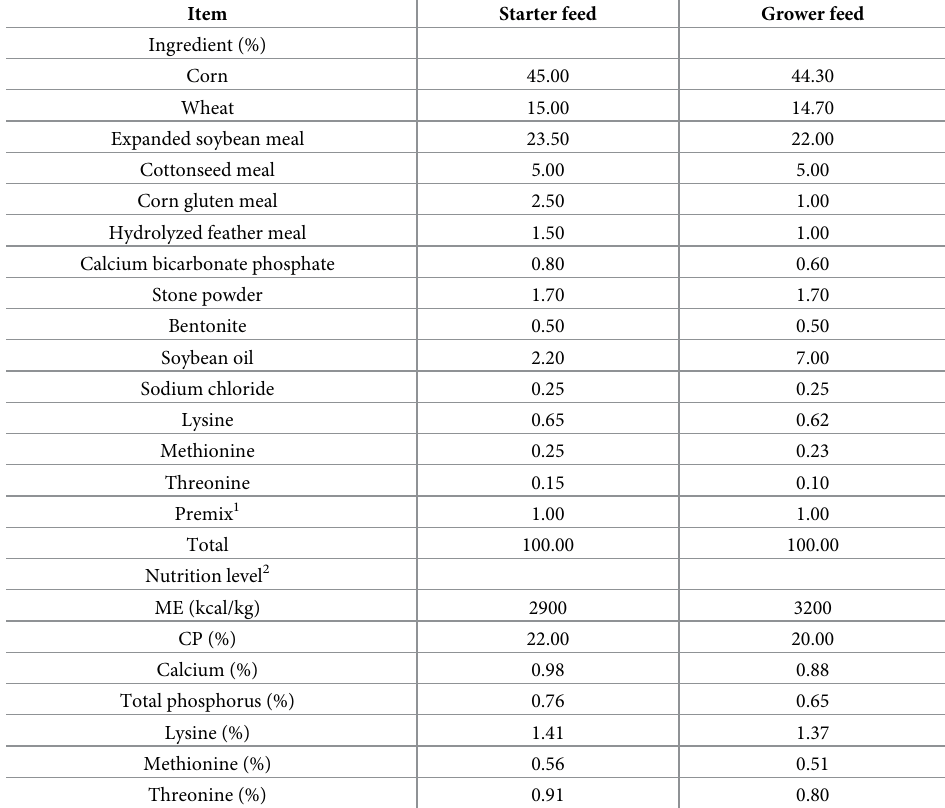
Table 1. Ingredient (%) and nutritive value of a basal